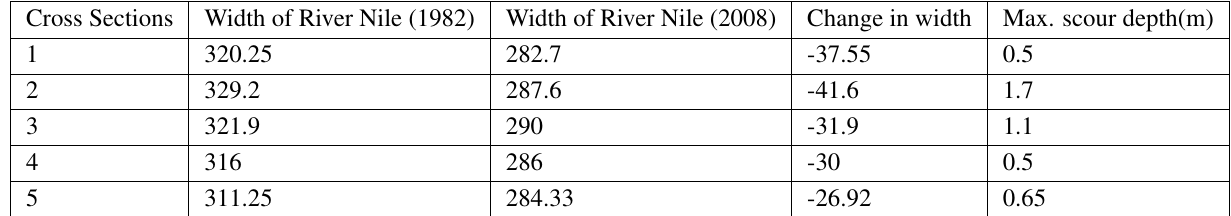
Table 2. The data of the River Nile cross sections down stream 6 th October Bridge